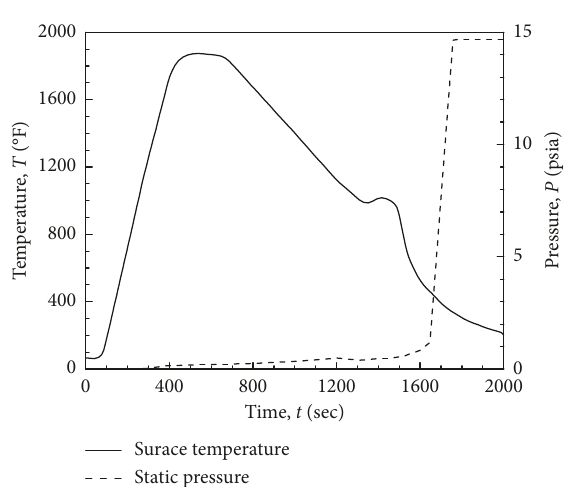
Figure 11: Temperature and pressure histories imposed during the radiant heating test of MTPS [22].